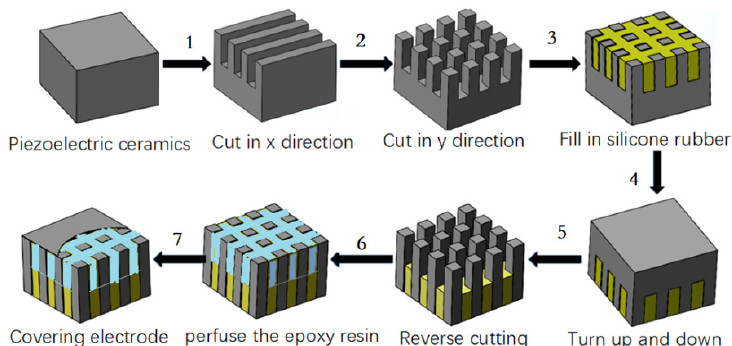
Figure 2. Fabrication flowchart of three-phase piezoelectric ceramic composites.